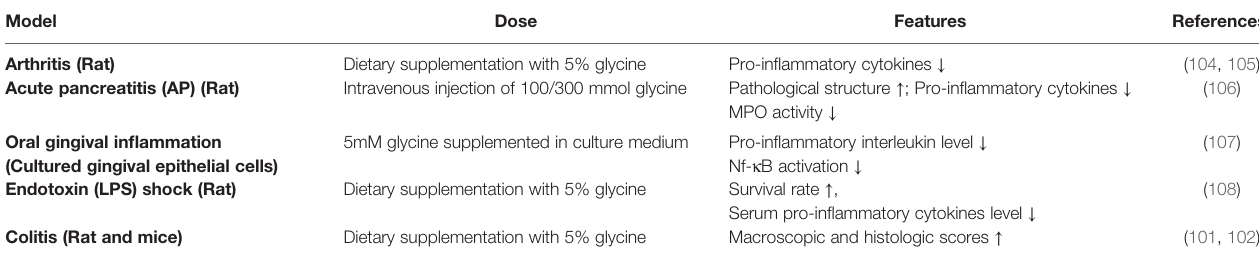
TABLE 2 | Bene fi cial effects of glycine in other macrophage-associated diseases.